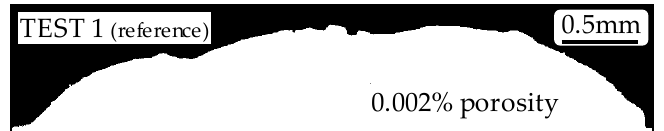
Figure 4. Tests No. 2, 3 and 4—5% concentration cutting fluid tests results.